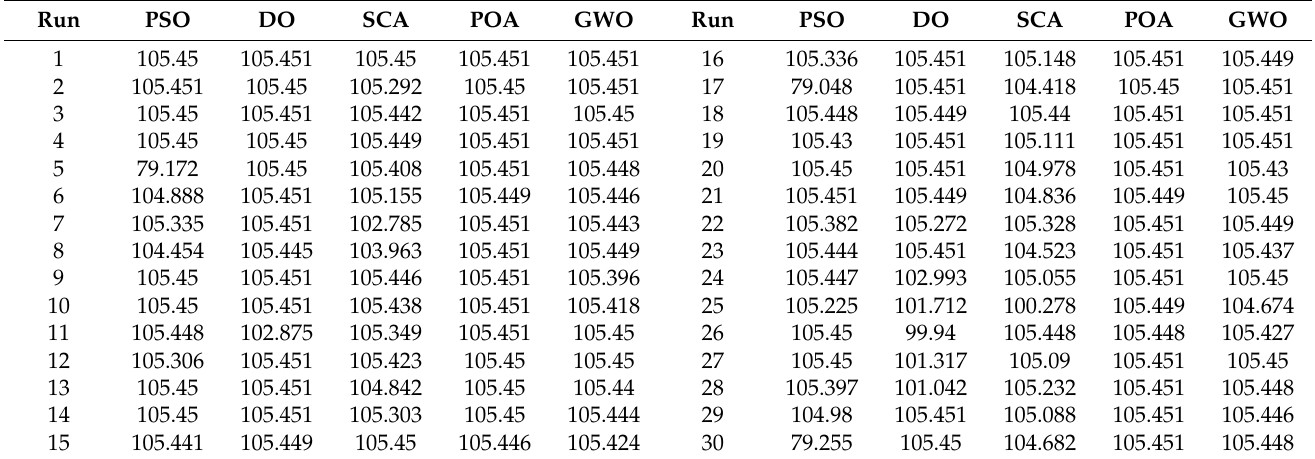
Table 3. Detailed results of 30 runs.